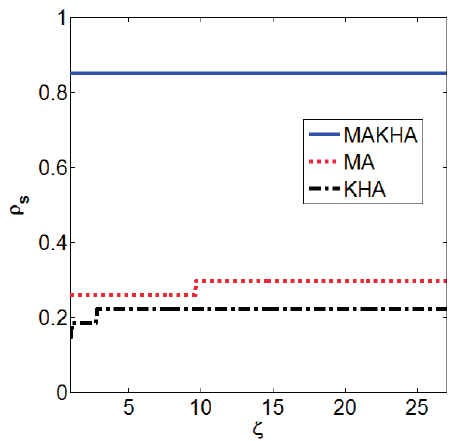
Figure 9. Performance profiles of the MAKHA, MA, and KHA methods for the global optimization of the twenty-seven benchmark problems used in this